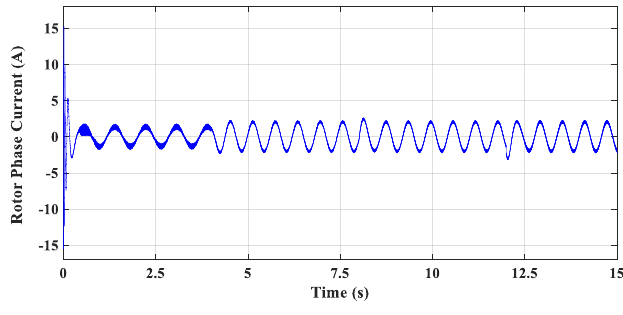
Figure 10. Rotor phase-current response.